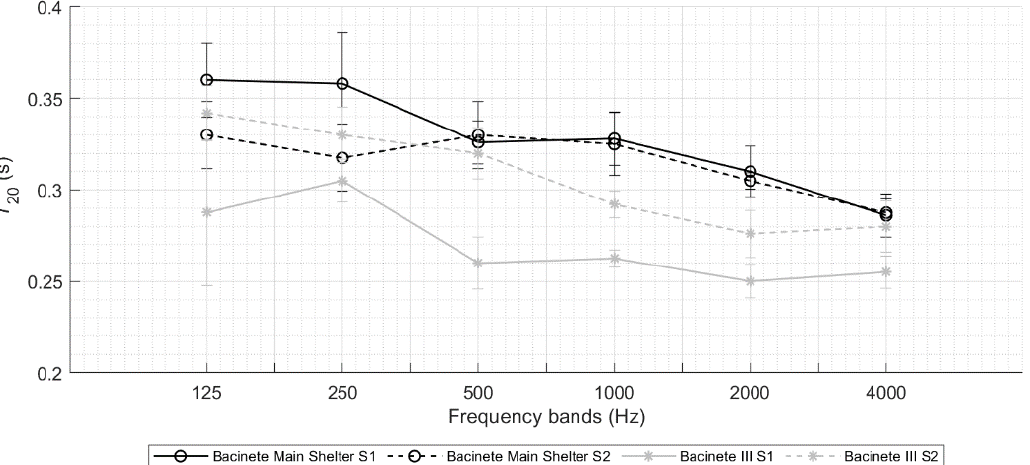
Figure 6. Reverberation time ( T 20 ) obtained in each shelter of the Bacinete rock art complex: Bacinete main shelter; Bacinete III. Spatially averaged values for each source location are represented at each frequency band.